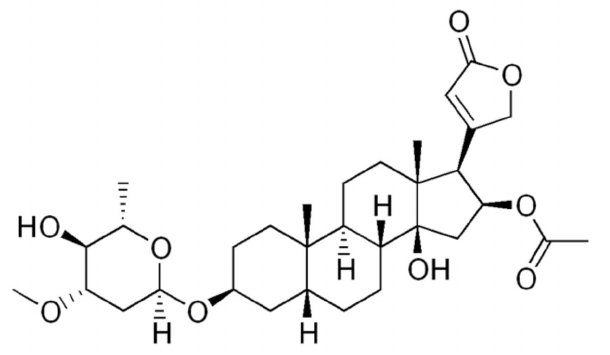
Figure 16. Structure of